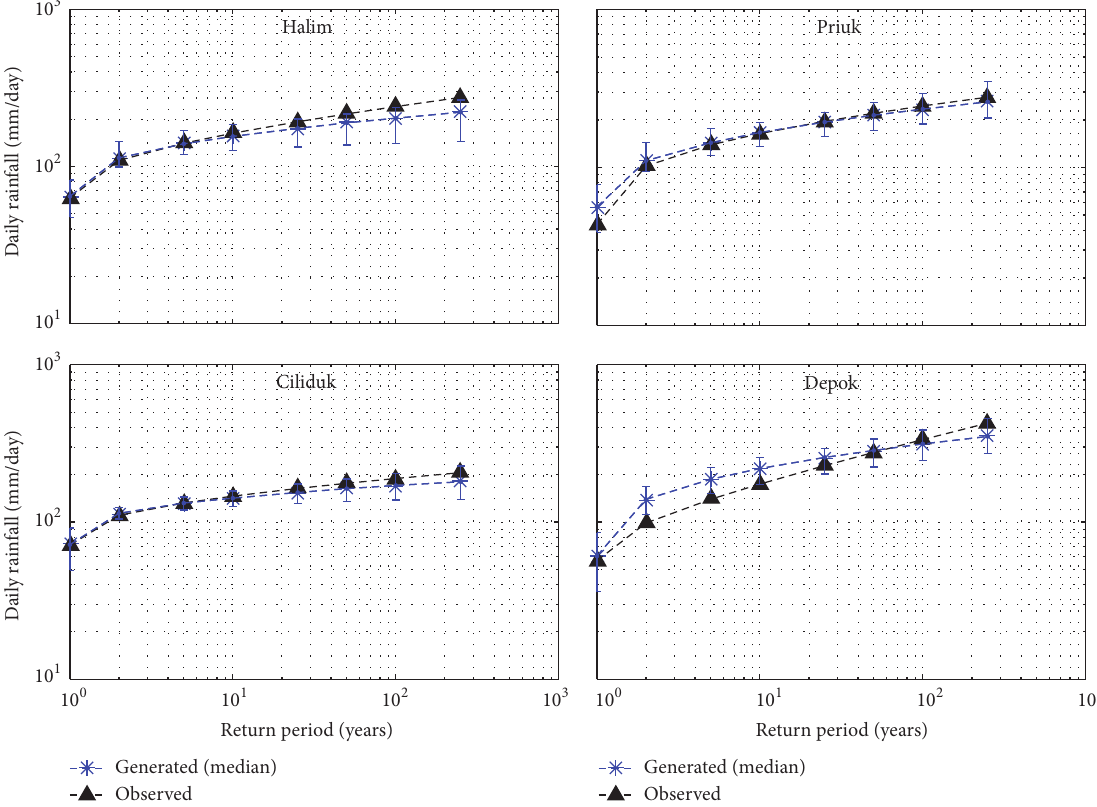
Figure 5: Comparison of RP curves obtained from observation with those from LARS-WG generated rainfall. Whiskers indicate minimum and maximum rainfall obtained from 100